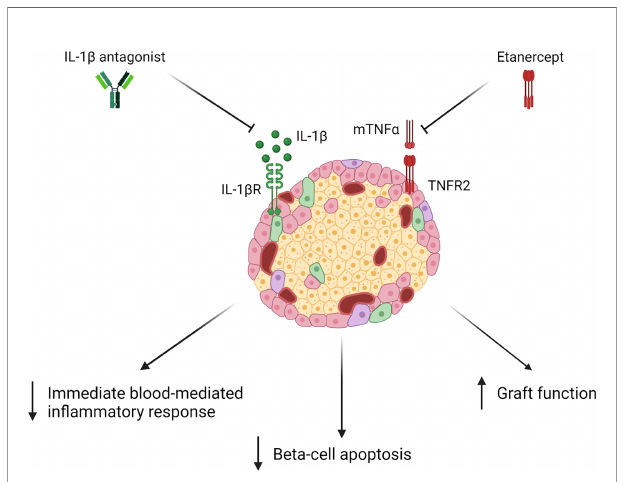
FIGURE 2 | Upon administration of Etanercept with an IL-1 b antagonist, studies have shown a decrease in immediate blood-mediated in fl ammatory response (IBMIR), beta-cell apoptosis, and an improvement in graft function (84 –